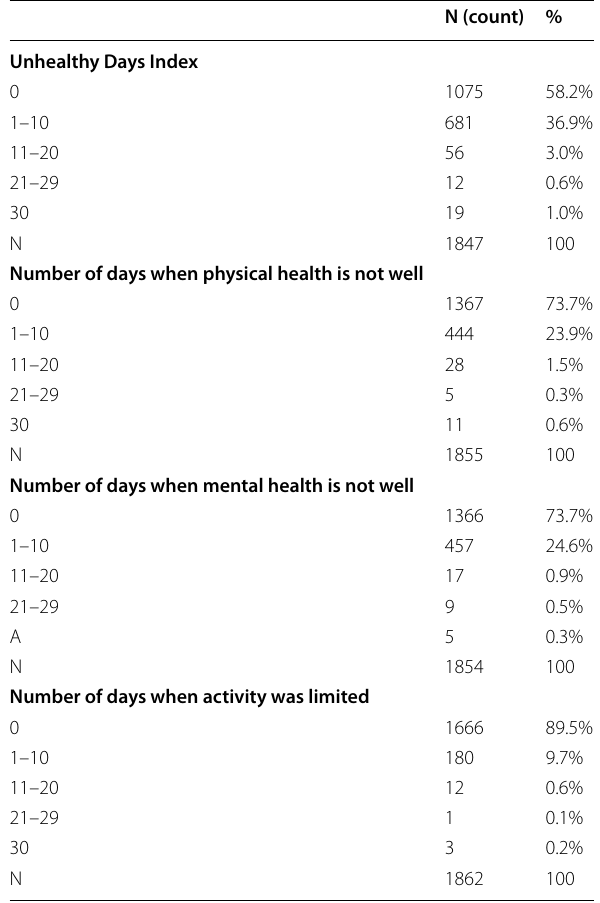
Measure for the Population Subgroup of ‘11111’ Health State of